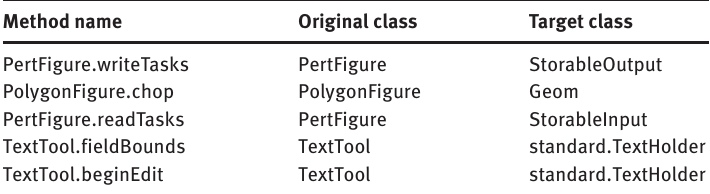
Table 3. Methods Should Be Moved for